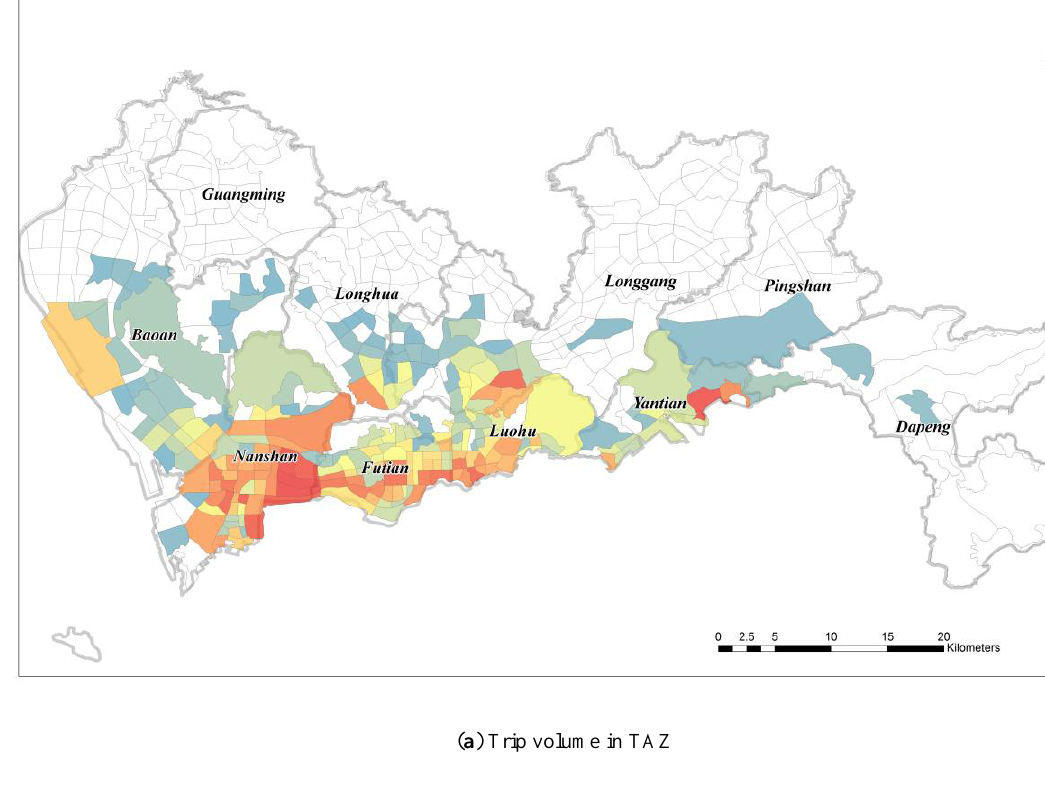
( a ) Trip volume in TAZ